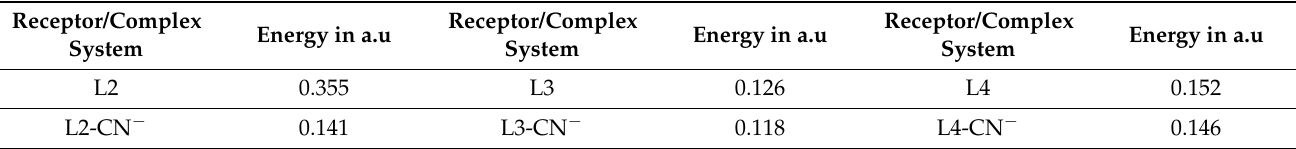
Table 1. Energy values (in a.u.) of receptors (L2–L4) and their complexes with CN − determined using DFT calculations. Receptor/Complex System